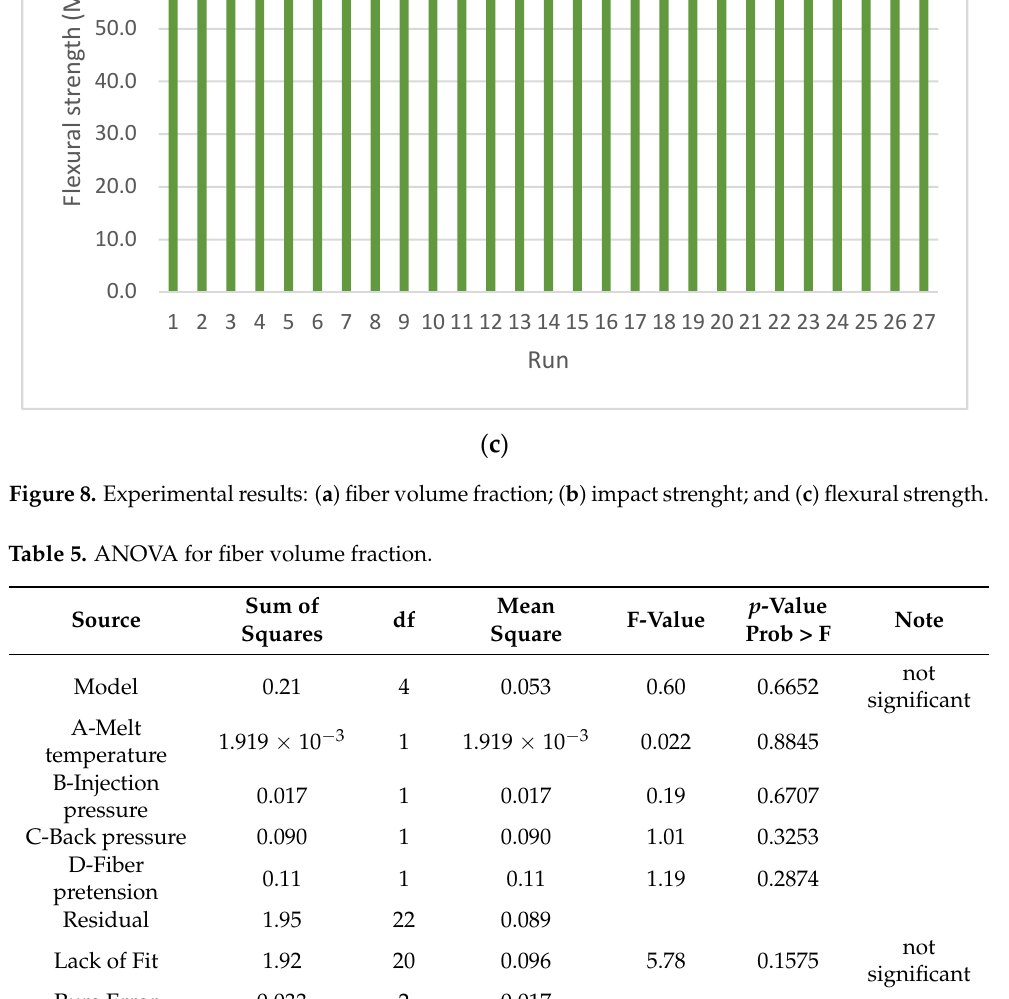
Table 5. ANOVA for fiber volume fraction.